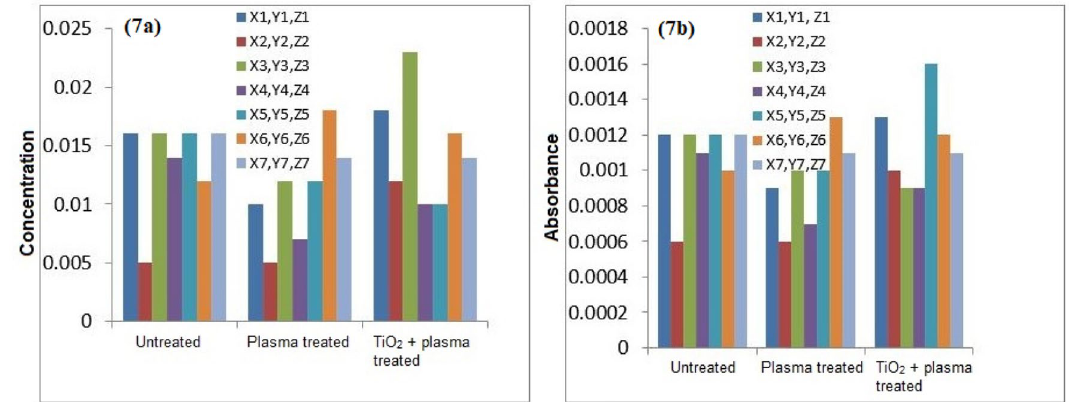
Figure 7. ( a ) Comparison of Cr concentration (mg/l), ( b ) Comparison of Cr absorbance (mg/l).